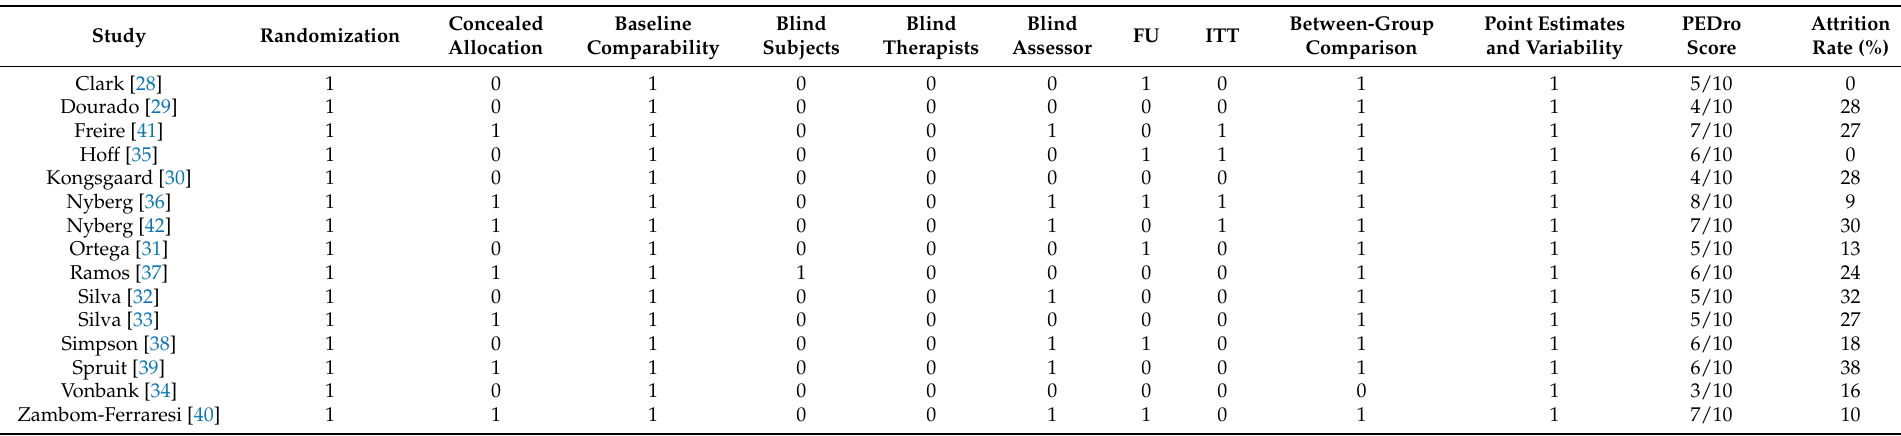
Table 1. Quality assessment of the included studies.